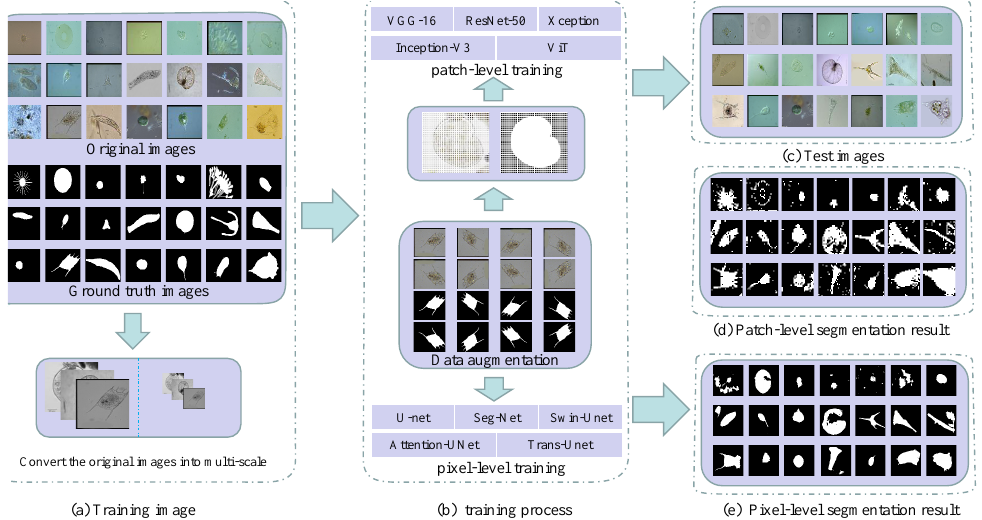
Figure 2. Workflow of patch-level and pixel-level segmentation in transparent images (using envi- ronmental microorganism EMDS-5 images as examples) (( a ) is the image of the training set and the grayscale of the original image. ( b ) is the patch-level and pixel-level training process. In ( c ) is the test set image. ( d , e ) are patch-level and pixel-level segmentation results,